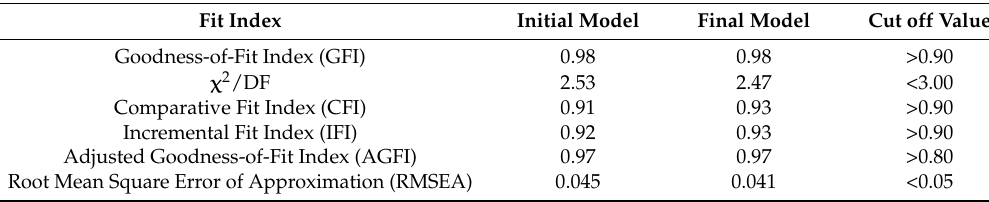
Figure 4. Path diagram of the Final model. Table 2. Overall goodness of fit